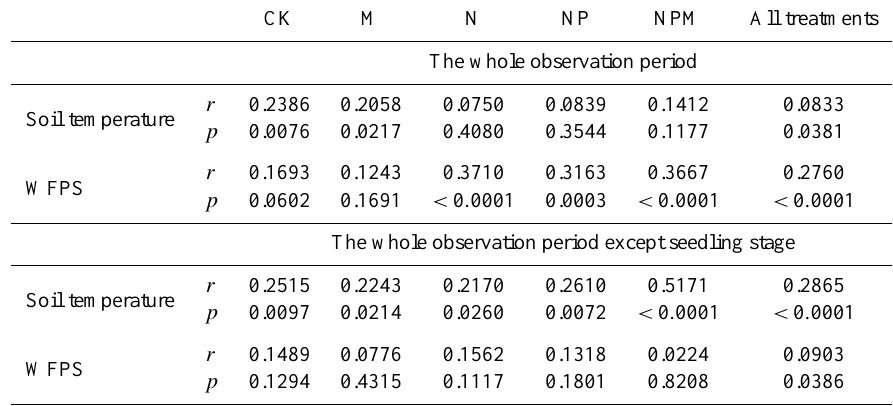
Soil temperature